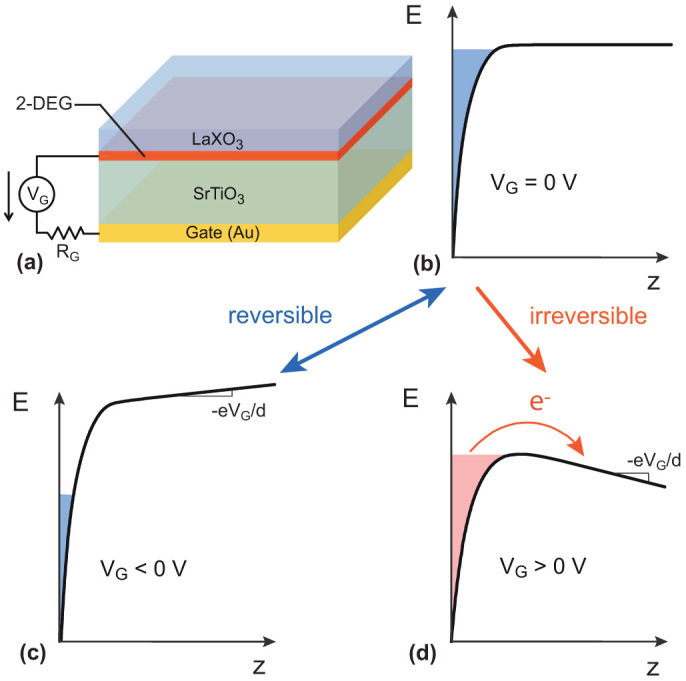
(a) Schematic of an LaXO3(X = Al, Ti)/SrTiO3 sample with a metallic back gate. (b,c,d) Illustration of filling the quantum well for different VG regimes. Starting from VG = 0, applying a negative gate voltages VG < 0 reversibly empties and fills the well. In contrast, applying the first positive polarisation (VG > 0), causes electrons to irreversibly escape from the well. The slope −eVG/d (where d = 500 μm is the thickness of the SrTiO3 substrate) of the conduction band is indicated.